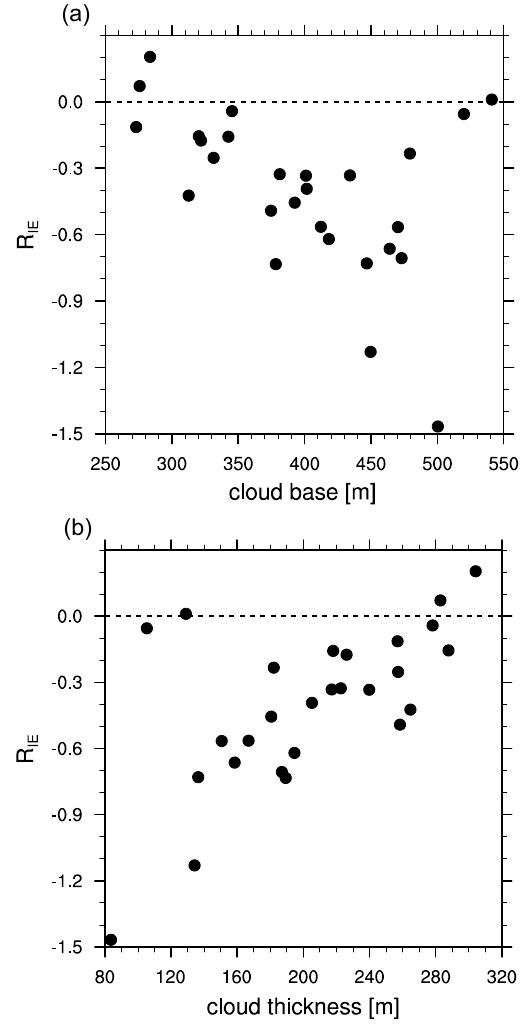
Fig. 15. The mean ratio of second to first indirect effect ( R IE ) for N a from 100 to 200 cm − 3 as a function of (a) cloud base height, and (b) cloud thickness. The data points are averaged over 4–7h.